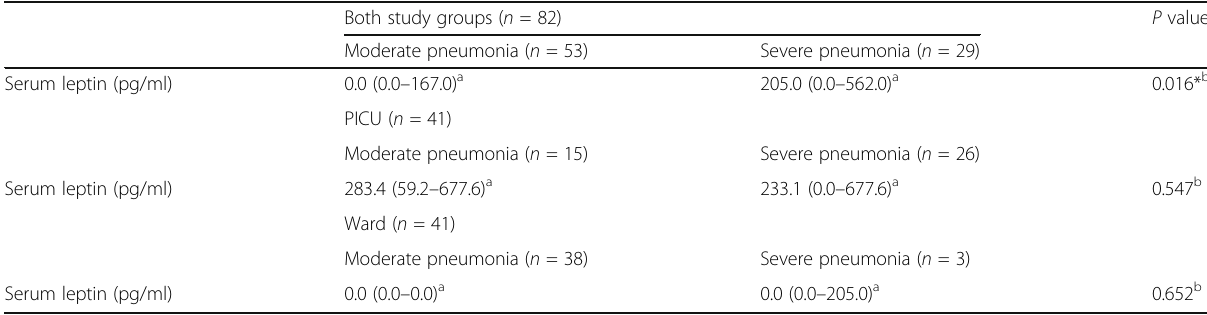
Table 3 Comparison of serum leptin between different grades of pneumonia severity Both study groups ( n = 82)